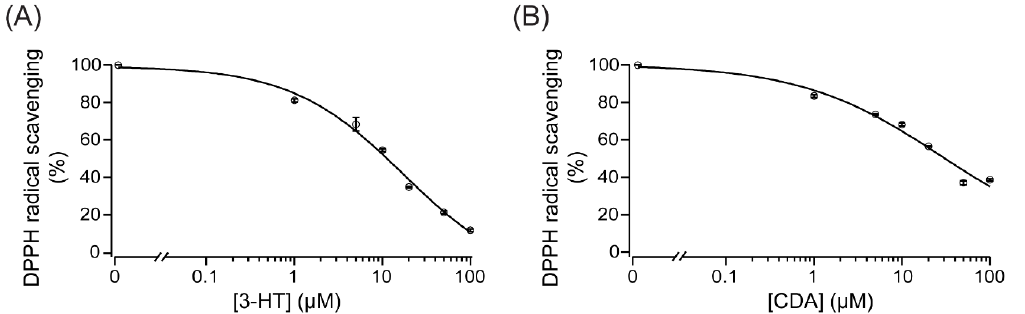
Figure 7. Direct reactive oxygen species (ROS) scavenging activity of 3-hydroxyterphenyllin (3-HT) ( A ) and candidusin A (CDA) ( B ). The antioxidant potential of 3-HT and CDA was evaluated by using the 2,2 ‐ diphenyl ‐ 1 ‐ picrylhydrazyl (DPPH) assay. DPPH was dissolved in 99% ethanol. Con ‐